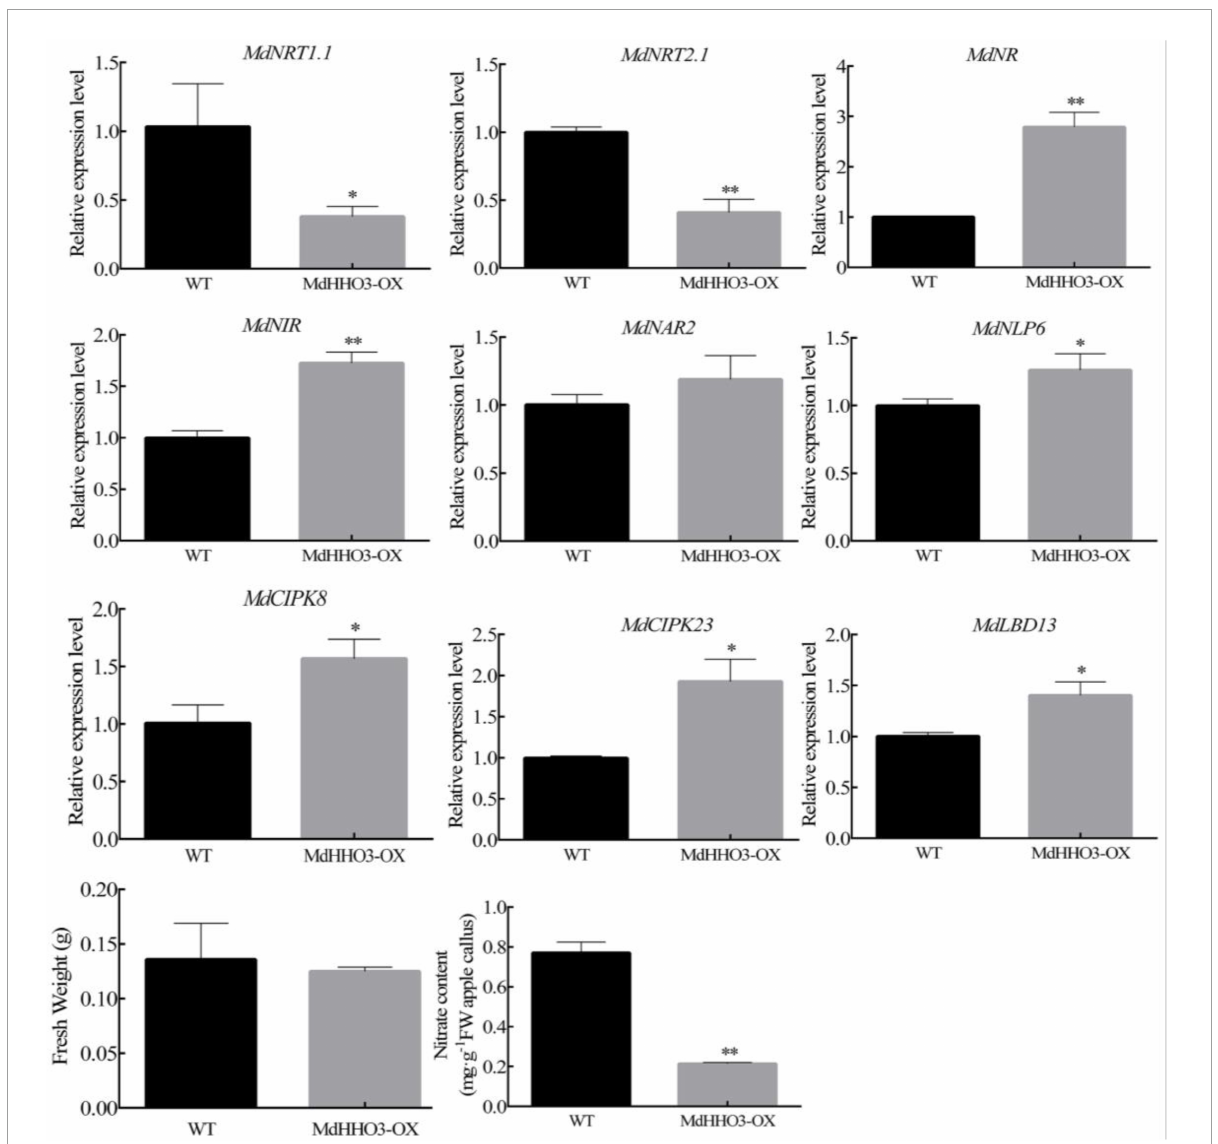
FIGURE5 Expression of the nitrate regulatory genes ( MdNRT1.1 , MdNRT2.1 , MdNR , MdNIR , MdCIPK8 , MdCIPK23 , MdNAR2 , MdNLP6, and MdLBD13 ) in 2-week-old apple calli (WT, wild-type; MdHHO3-OX, with the MdHHO3 overexpression construct). The value for the WT control was set to 1. Three biological replicates of each sample were included, and the data are expressed as the means ± SDs ( n = 3). Significant differences were detected by a t -test: ∗ P < 0.05 and ∗∗ P <